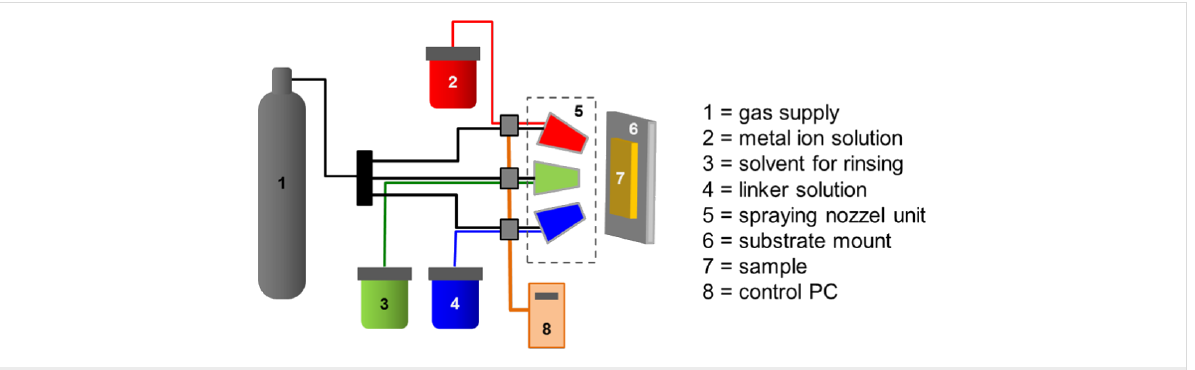
Figure 9: Setup employed for the fabrication of MOF thin films with the spray method